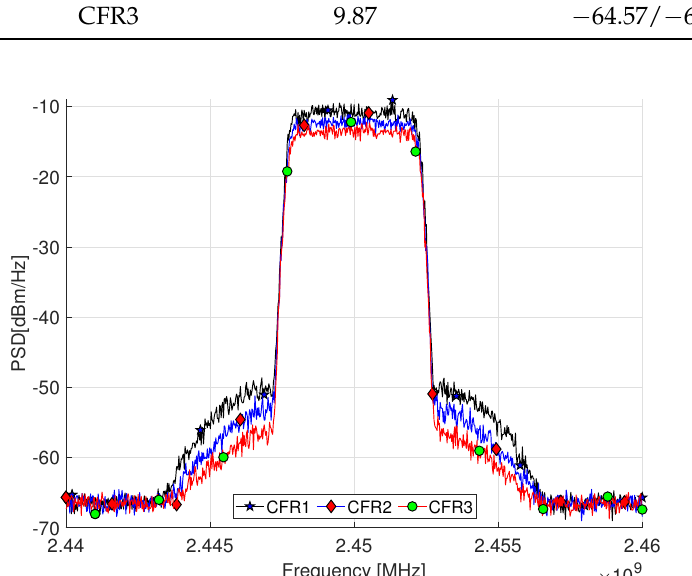
Figure 8. PSD of LTE 5–MHz OFDM waveform signal with residual spectral regrowth after CFR using three scale